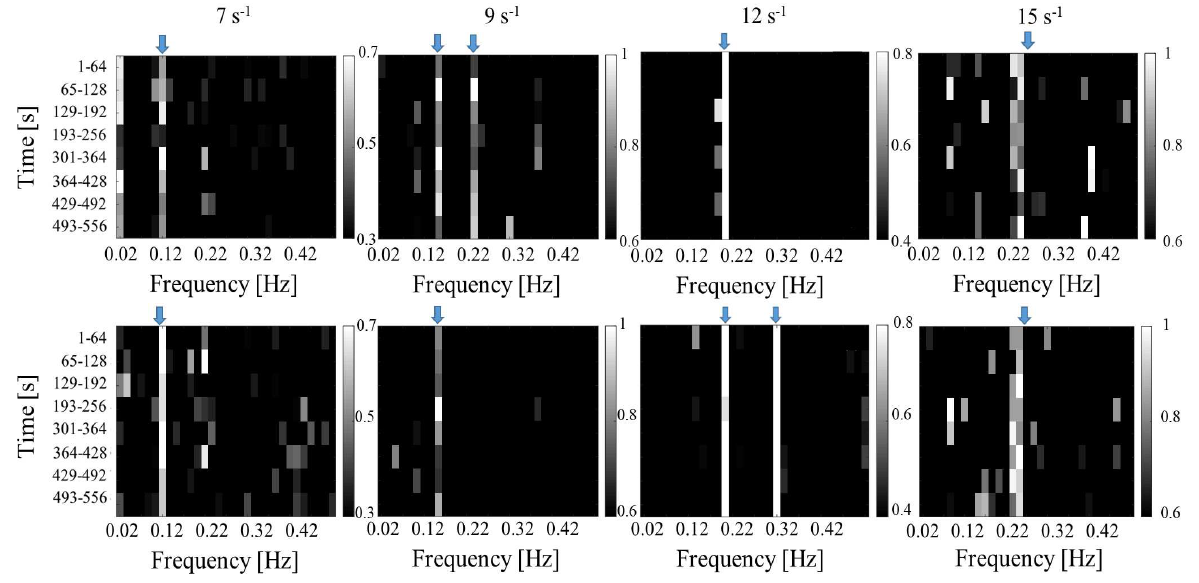
Figure 9: Frequency images from the Fourier transform of the time correlation functions for interface position. The scale bars correspond to amplitude (intensity normalized by the maximum intensity) in arbitrary units (a.u.). The top panels are protocol 1 (no pre-shear) and the bottom panels are protocol 2 (with pre-shear) with increasing shear rate (7, 9, 12 and 15 s −1 ) from left to right. The dominant frequencies in the spectra are shown with blue